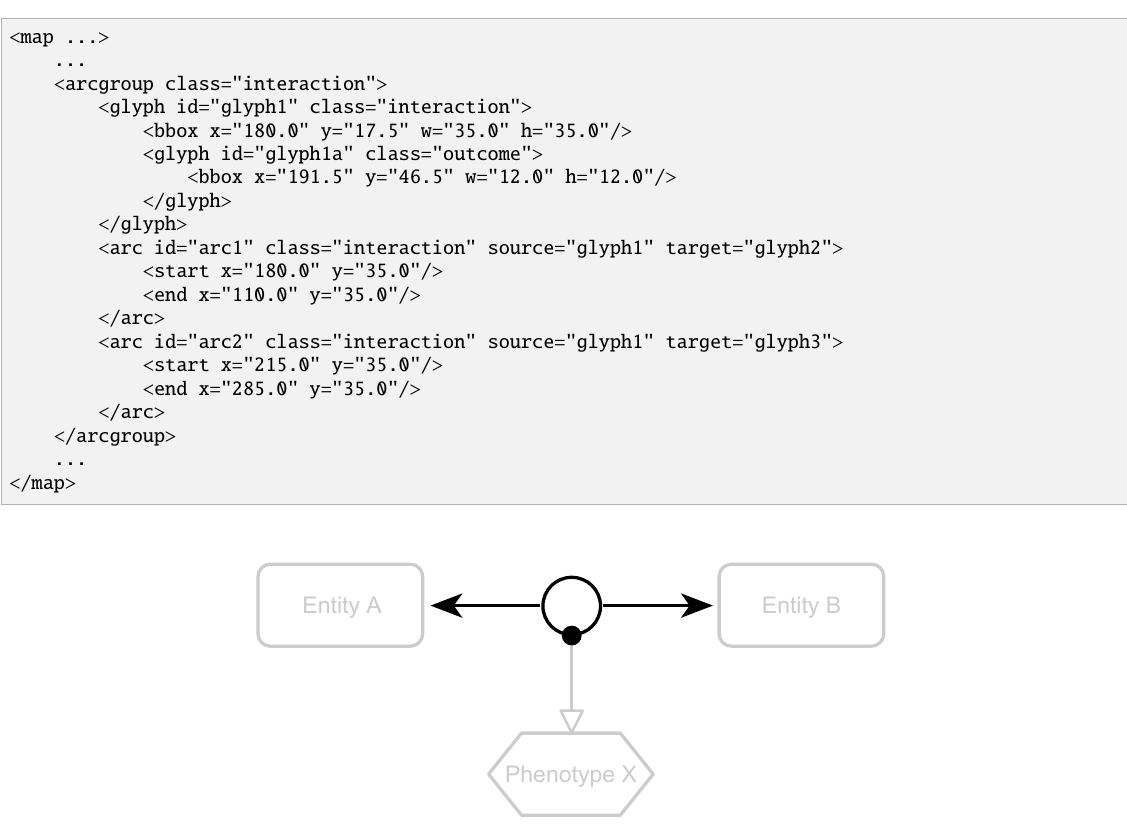
Section 2 Package syntax and